Question: What caption would you write for this figure?
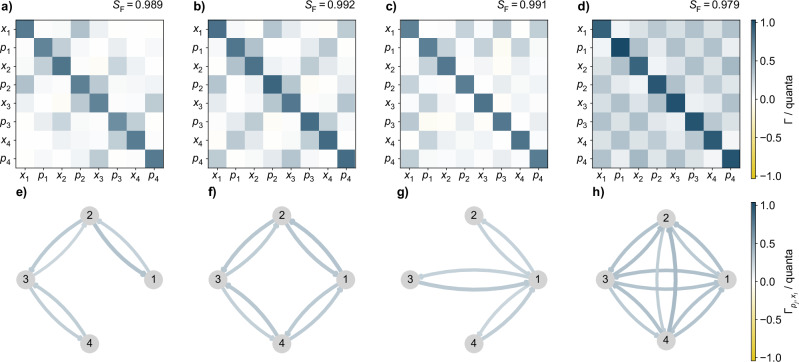
Answer: Quadrature covariance matrices and inferred graph connectivity. a – d Reconstructed covariance matrix Γ of the quadrature operators at P p = −24 dBm, extracted from heterodyne detection of four frequency modes clustered in linear ( a , e ), cyclic ( b , f ), star ( c , g ), and fully-connected ( d , h ) configurations. e – h Evaluation of the graph connectivity inferred from the elements of the covariance matrix, with the color of the arrow pointing from the j -th to the l -th node mapping the value of the \documentclass[12pt]{minimal} \usepackage{amsmath} \usepackage{wasysym} \usepackage{amsfonts} \usepackage{amssymb} \usepackage{amsbsy} \usepackage{mathrsfs} \usepackage{upgreek} \setlength{\oddsidemargin}{-69pt} \begin{document}$${\Gamma }_{{p}_{j},{x}_{l}}$$\end{document} Γ p j , x l term.